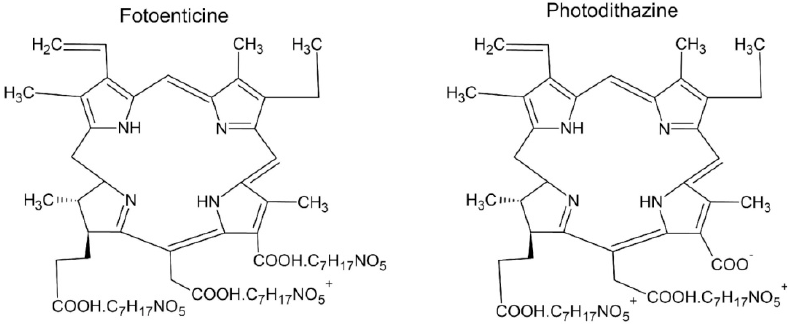
Figure 1. Chemical Structure of the Fotoenticine and